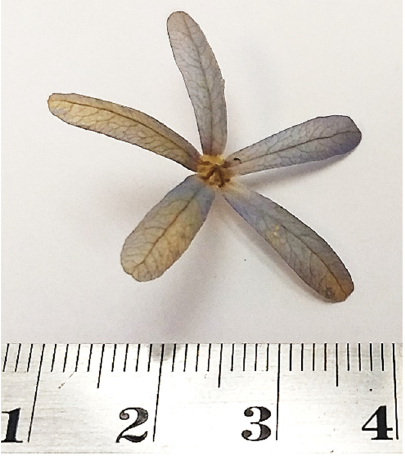
Figure 1. Petrea Volubilis seed, so-called Queen’s Wreath. Units in centimeters.